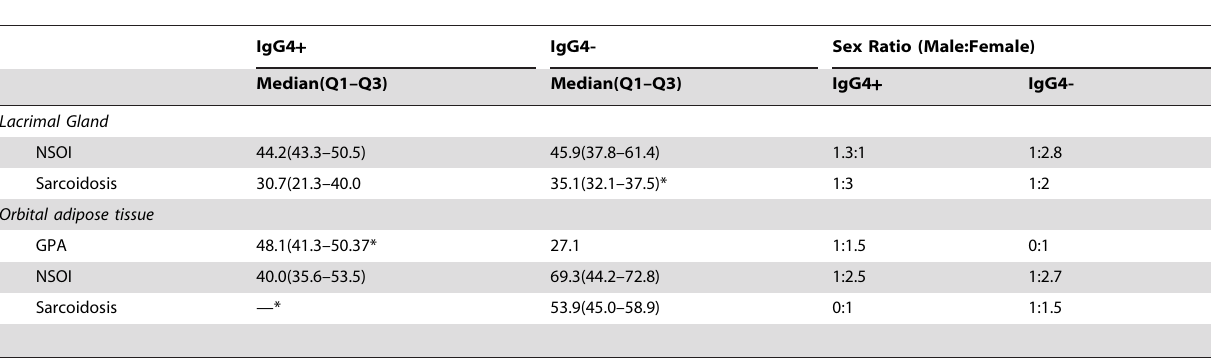
Table 3. IgG4 status is independent of age and